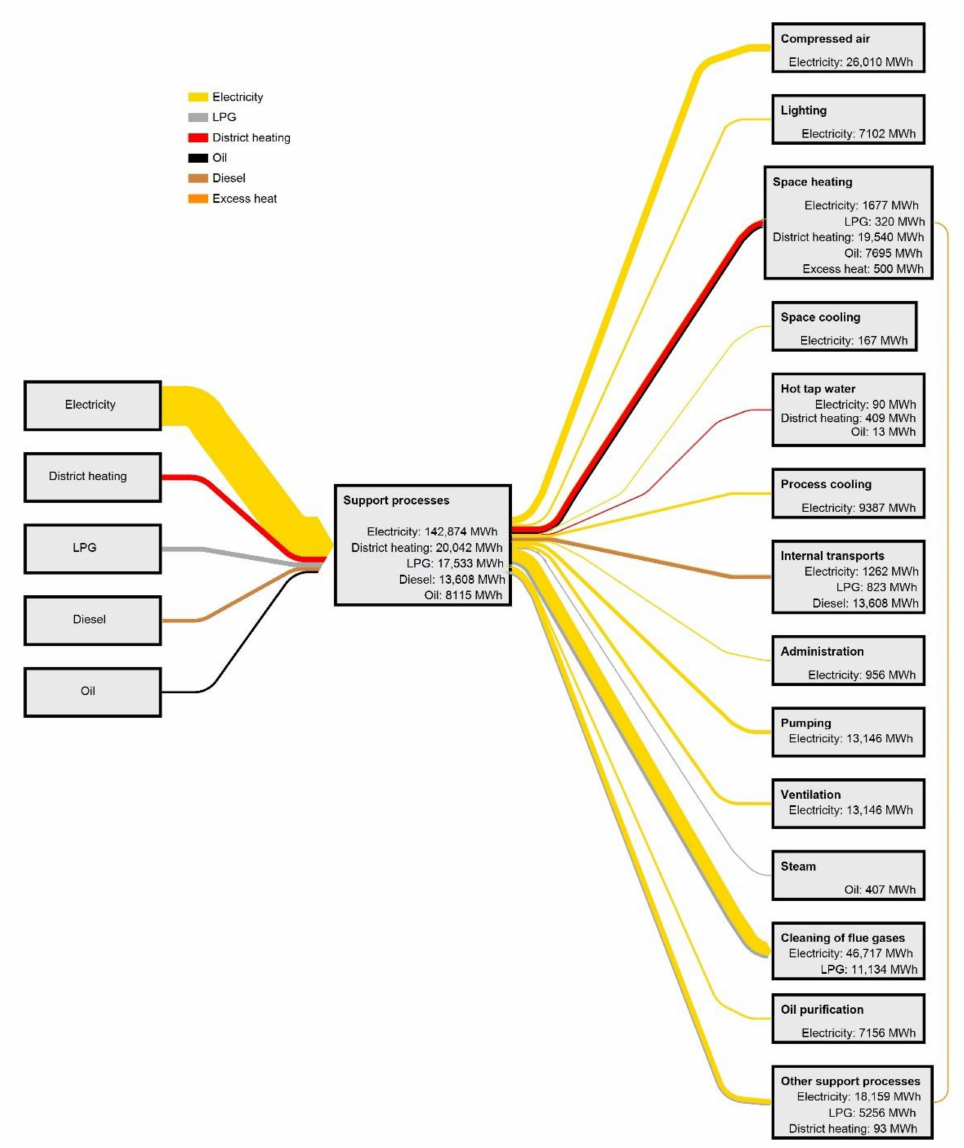
Figure 8. The energy end-use of the aluminium industry and two aluminium casting foundries in Sweden regarding support processes. Processes occurring at several companies in the supply chain have been combined into one entry